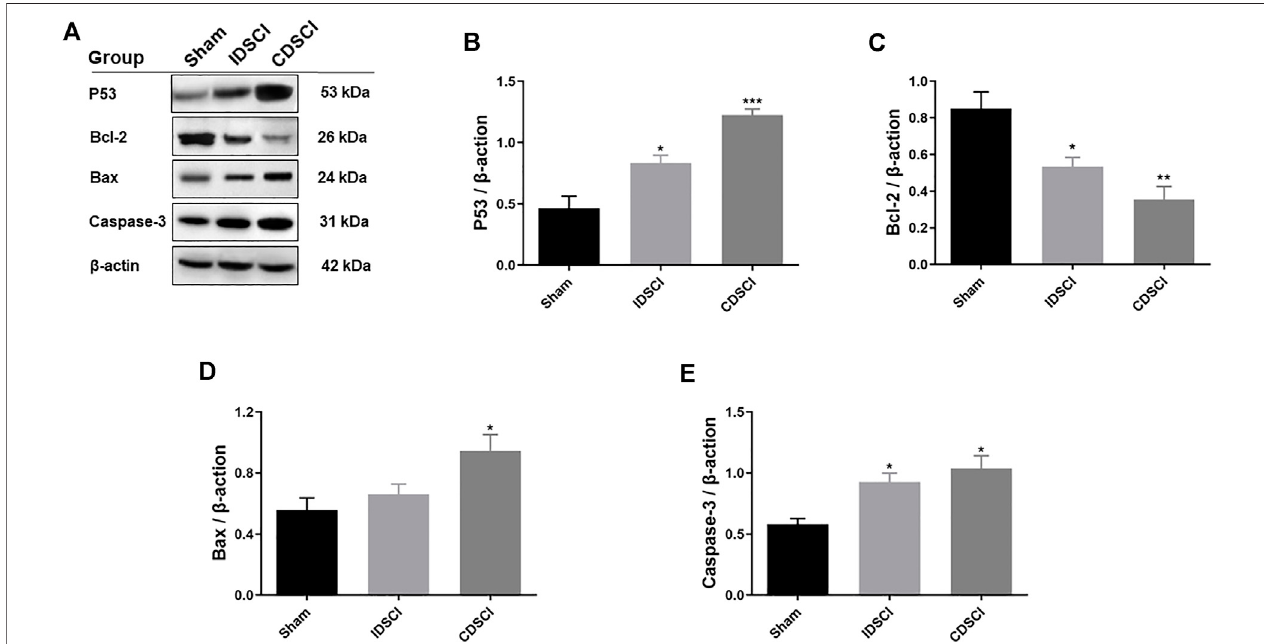
FIGURE 7 | Determination of the expression levels of P53/Bcl-2/Bax/Caspase-3 signaling pathway-related proteins following DSCI. (A) The representative immunoblots of Bcl-2, Bax, Caspase-3, P53 and β -actin are listed. (B – E) Grayscale values were determined using ImageJ software based on the bands in the immunoblots ( n = 3). All values are expressed as means ± SD. * p < 0.05, ** p < 0.01, *** p < 0.001 vs. the sham group.